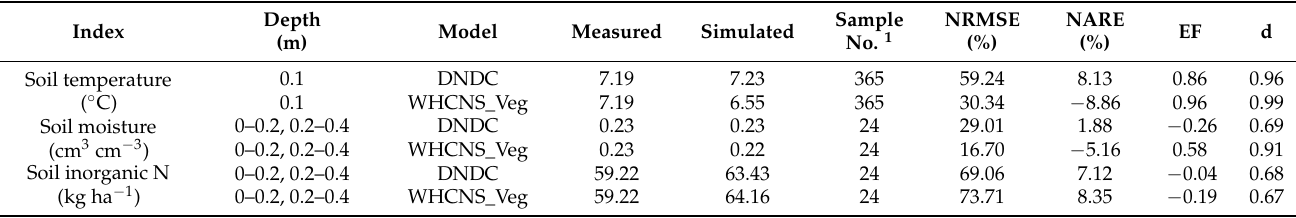
Table 5. Statistical calibration between the simulated and measured soil temperature, soil moisture and soil inorganic nitrogen using the DNDC and WHCNS_Veg models in Wuchuan, China.